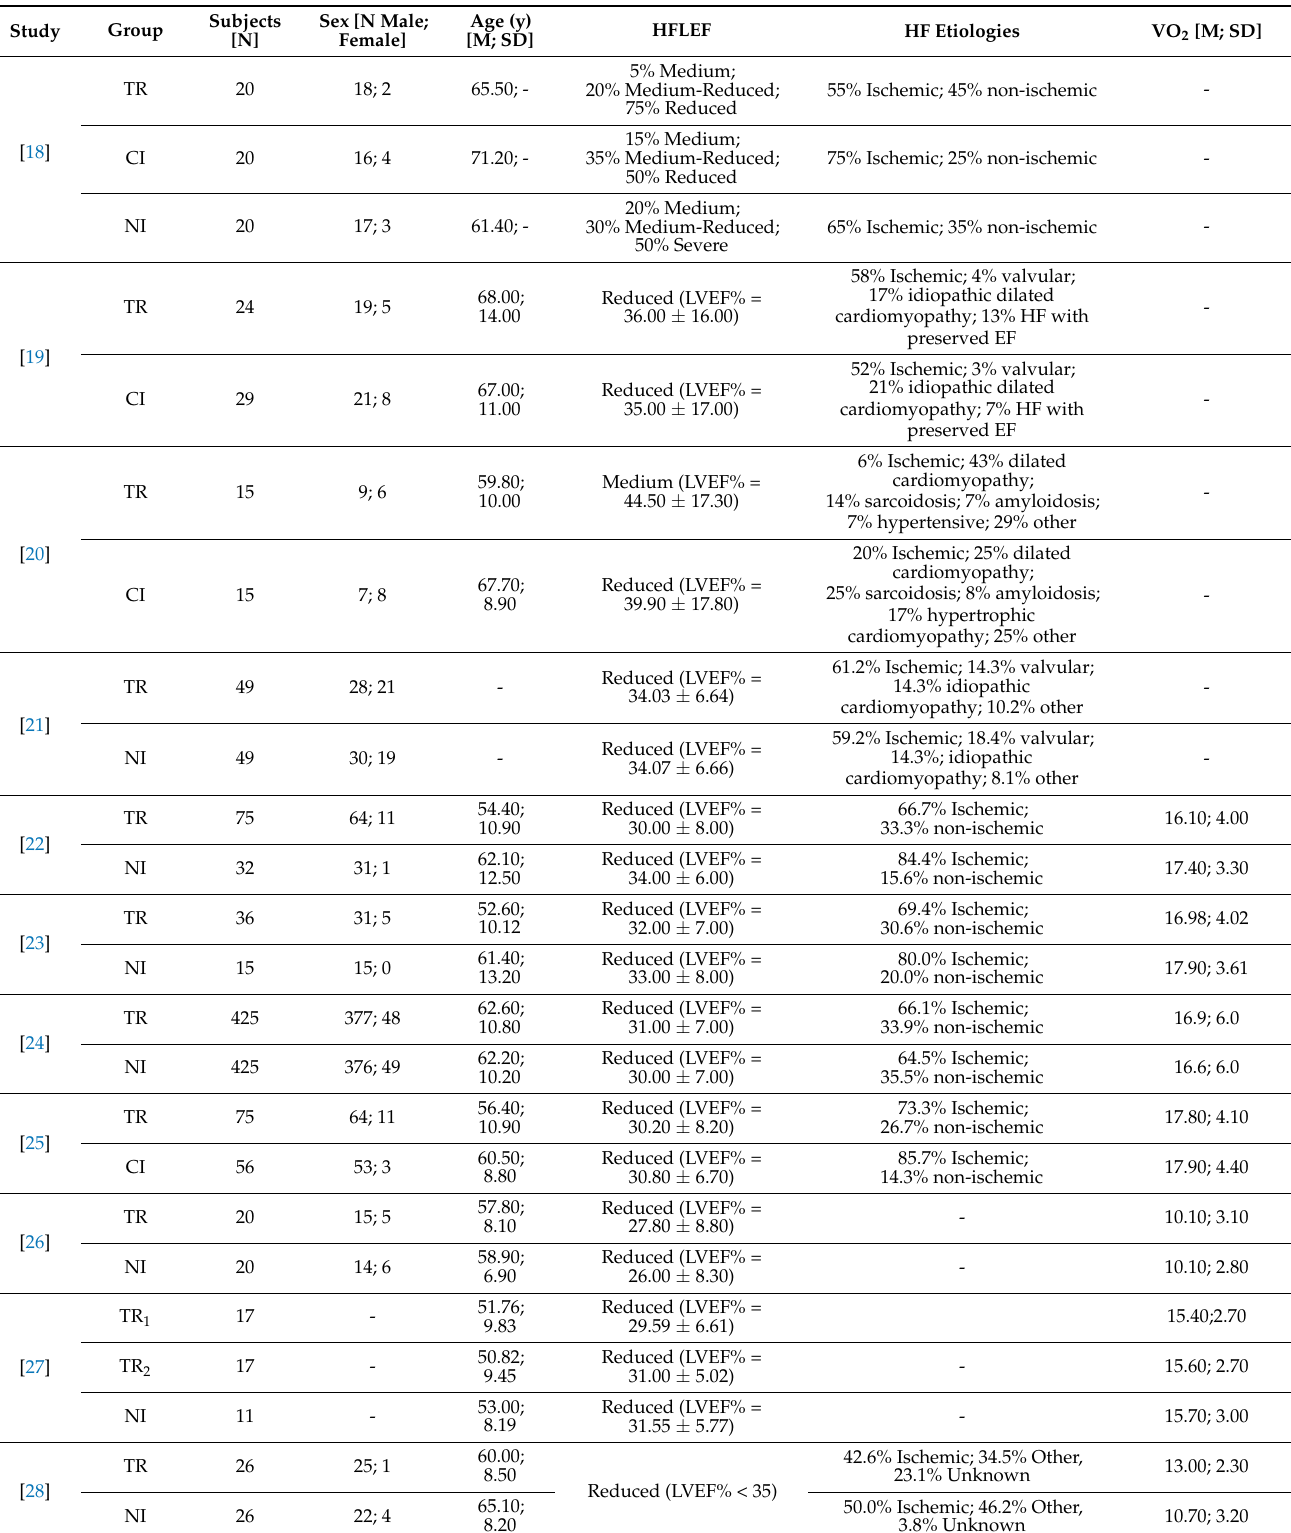
Table 2. Demographics and clinical characteristics of experimental and control groups of tri- als included in the systematic review. TR = Telerehabilitation; CI = conventional intervention; NI = no